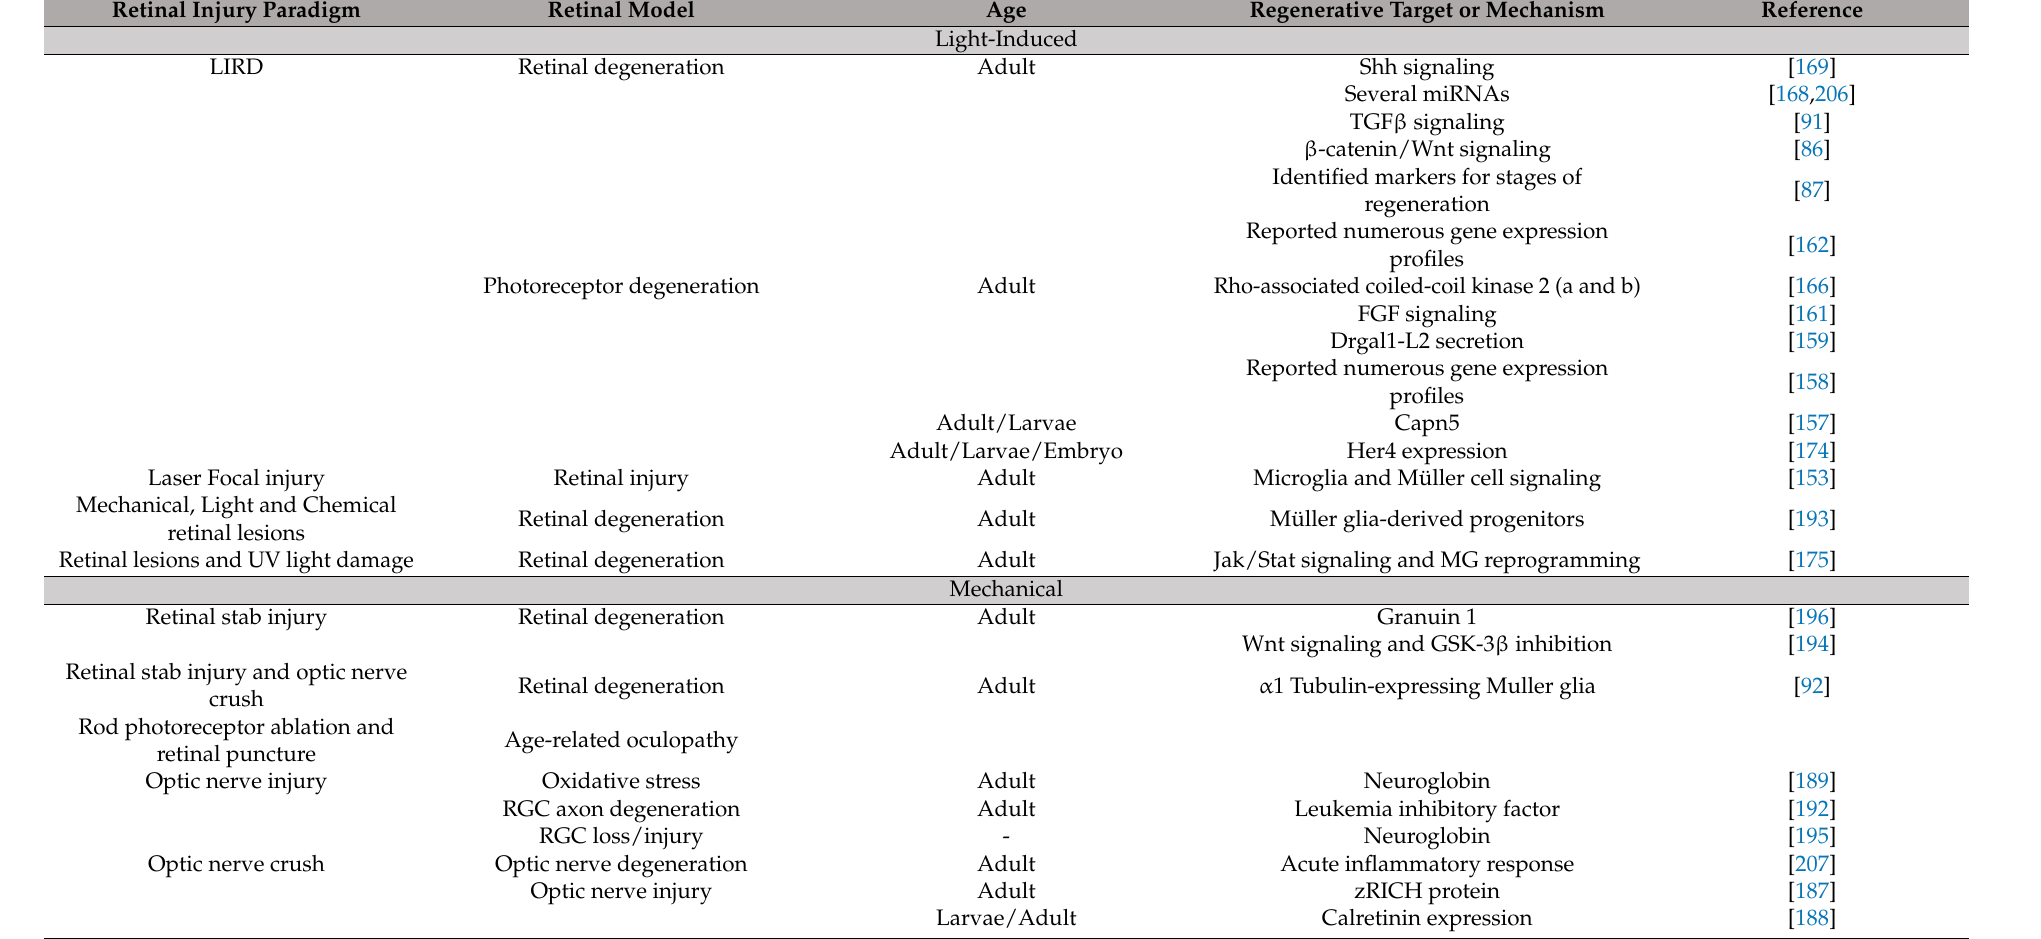
Table 2. Summary of retinal regeneration studies that use zebrafish retinal injury